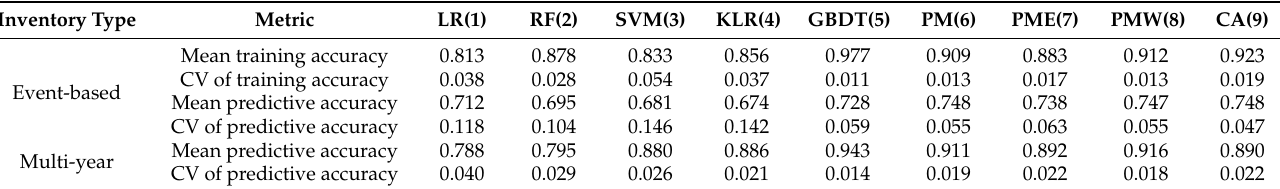
Table 10. Performance assessment of the different modeling methods.